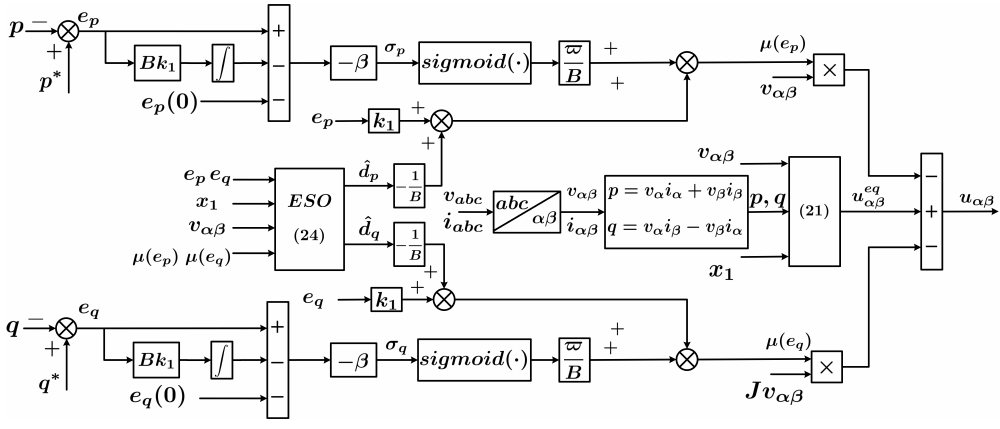
Figure 4. Control structure of power tracking